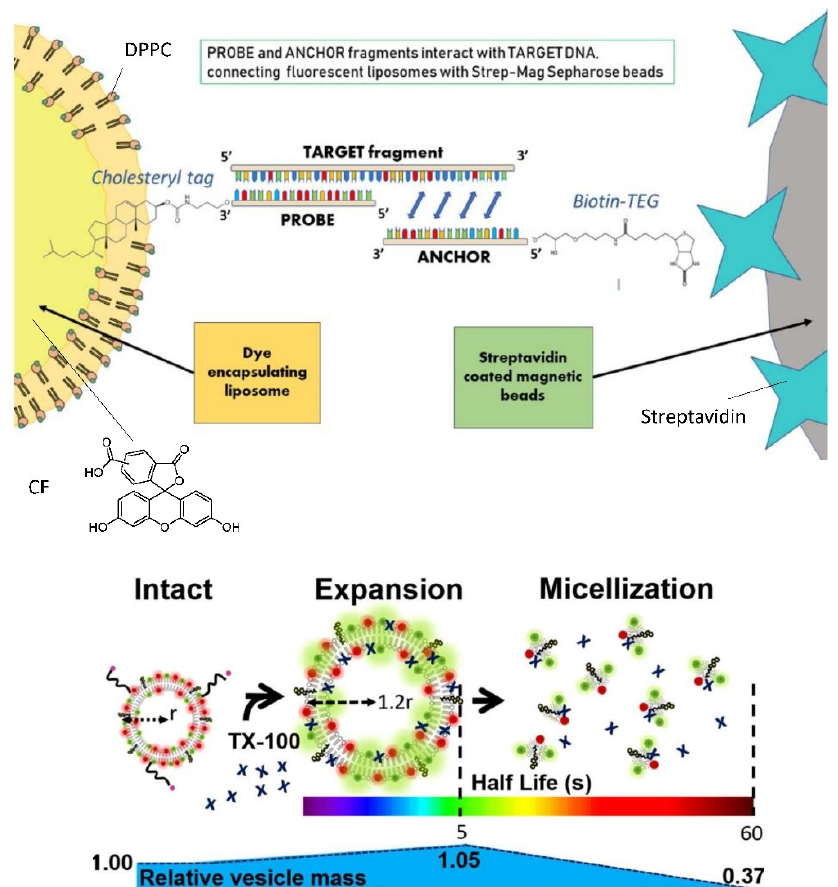
Figure 33. Application of dye-containing lipid vesicles in a bioassay for the quantitative determination of DNA, as published by Sforzi et al. (2020) [466]. Top : The first part of the assay of an oligonucleotide TARGET fragment as analyte is shown. This first part is the interaction between (i) DPPC LUVs containing encapsulated 5(6)-carboxyfluorescein (CF) at a self-quenching concentration and a membrane-embedded cholesteryl-PROBE conjugate, the PROBE being an oligonucleotide with a sequence that is complementary to the oligonucleotide sequence at the 5 ′ end of the TARGET fragment ( left hand side ) and (ii) streptavidin-coated magnetic Sepharose beads with a surface bound biotin-ANCHOR conjugate, the ANCHOR being an oligonucleotide with a sequence that is complementary to the oligonucleotide sequence at the 3 ′ end of the TARGET fragment ( right hand side ). The TARGET fragment acts as linker unit for the binding of the CF- loaded DPPC LUVs to the magnetic beads. Bottom: The second part of the assay is the release and quantification of CF from the beads-bound DPPC LUVs by adding the micelle-forming surfactant Triton X-100, as illustrated by Dalgarno et al. (2020) [478] for dispersed vesicles. “Expansion” means mixed lipid-detergent vesicles that increase in mass and size after addition of Triton X-100 before micellization starts; see [478] for details. Reproduced with permission from [466], American Chemical Society, 2020; and from [478], Springer Nature, 2019.